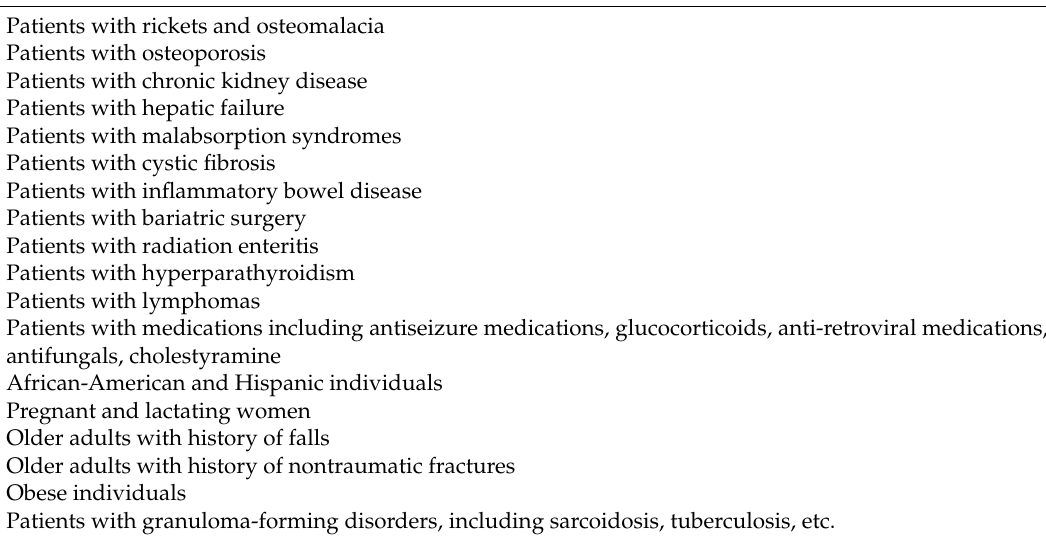
Table 2. Vulnerable populations for vitamin D deficiency ( adapted from the Endocrine Society clinical practice guidelines